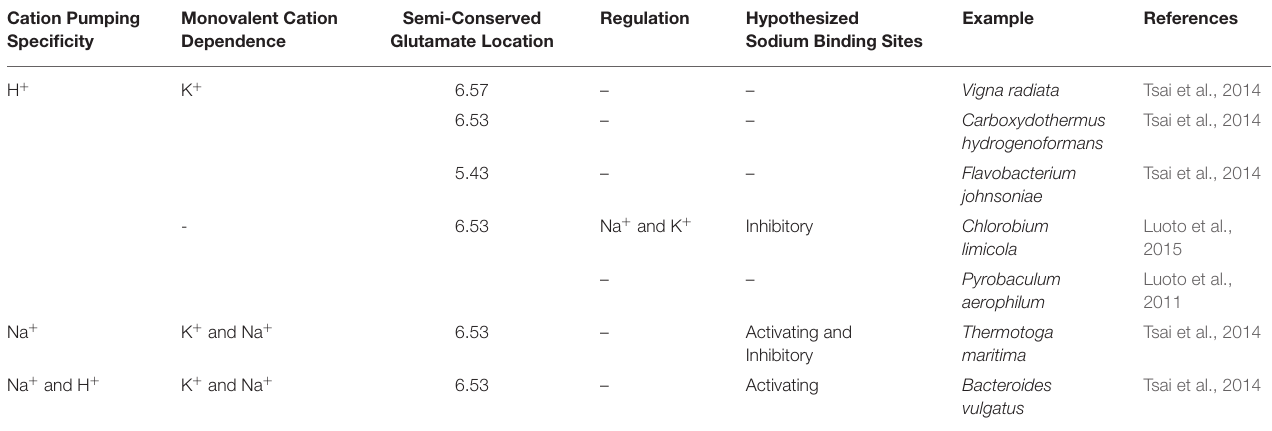
TABLE 1 | mPPase subfamily